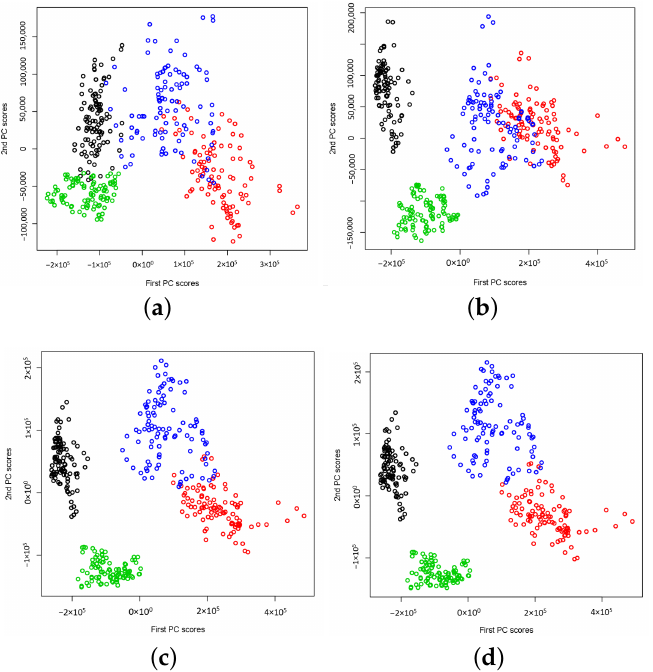
Figure 3. The plots of extracted two-dimensional principal component scores of CWT power spectra for data sets A (Normal: Eyes Closed, Black), B (Normal: Eyes Open, Red), C (Non-epileptogenic zone, Green) and D (Epileptogenic zone, Blue) respectively, with different values of K , the number of basis functions, ( a ) K = 5, ( b ) K = 20, ( c ) K = 25, ( d ) K =